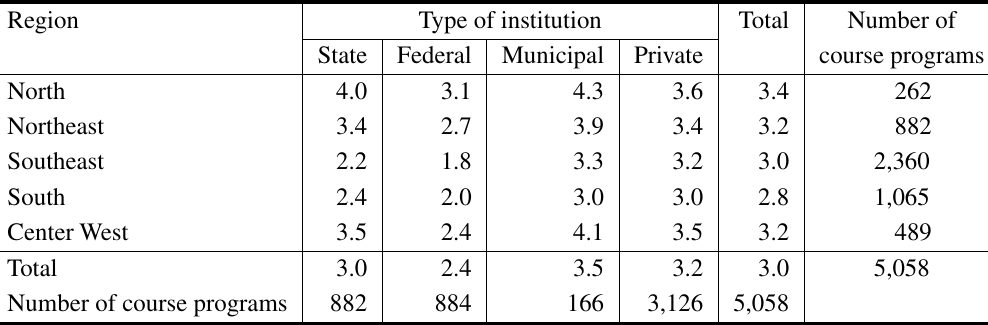
National Course Exam, mean scores of course programs,